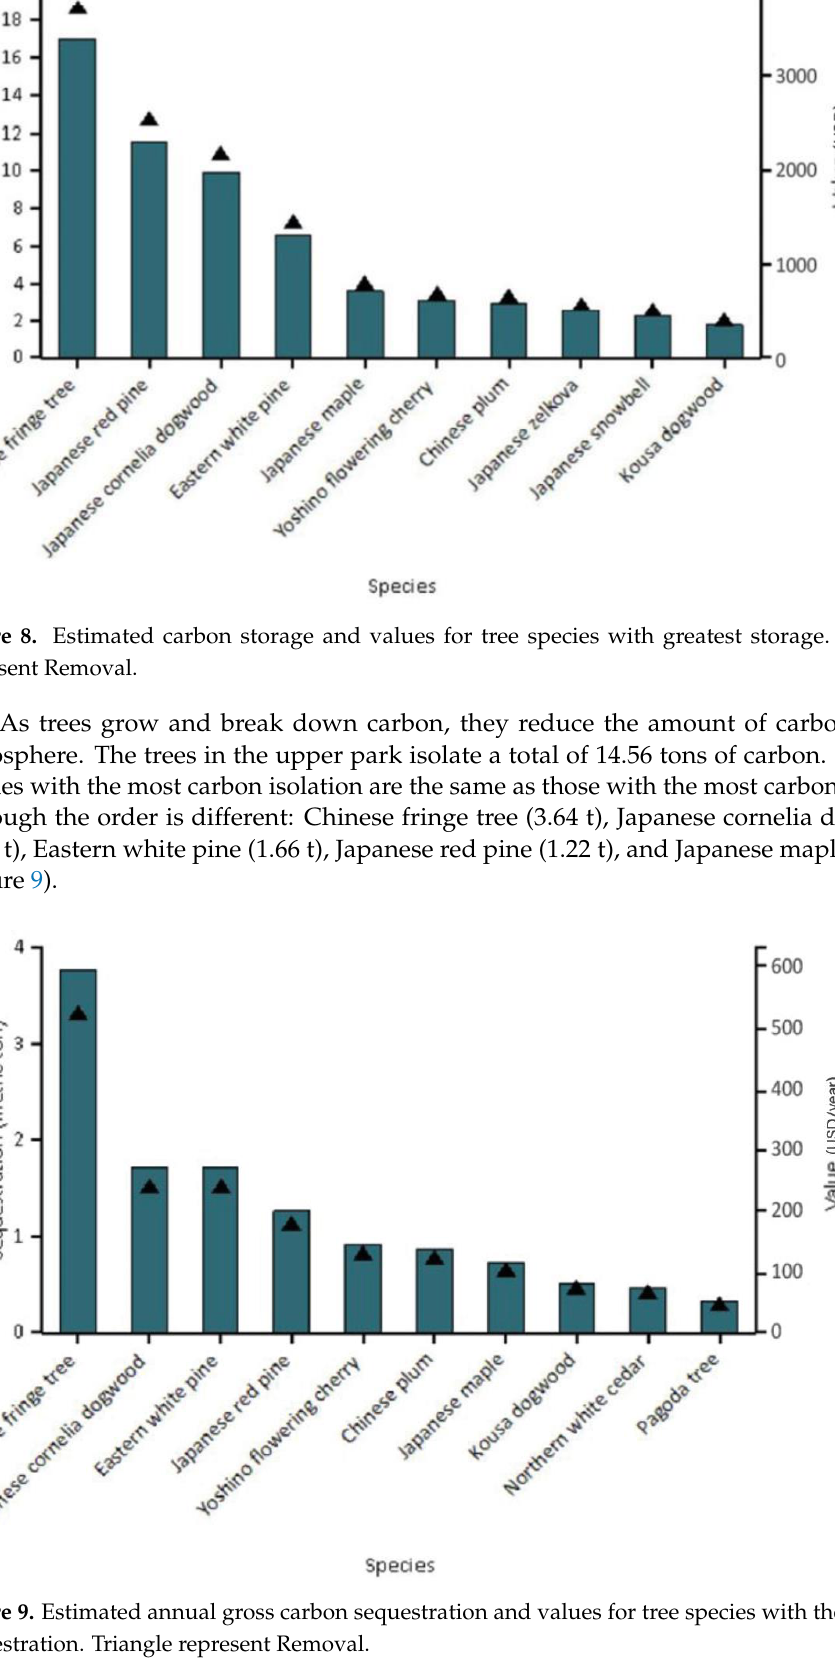
Figure 9. Estimated annual gross carbon sequestration and values for tree species with the greatest sequestration. Triangle represent Removal.